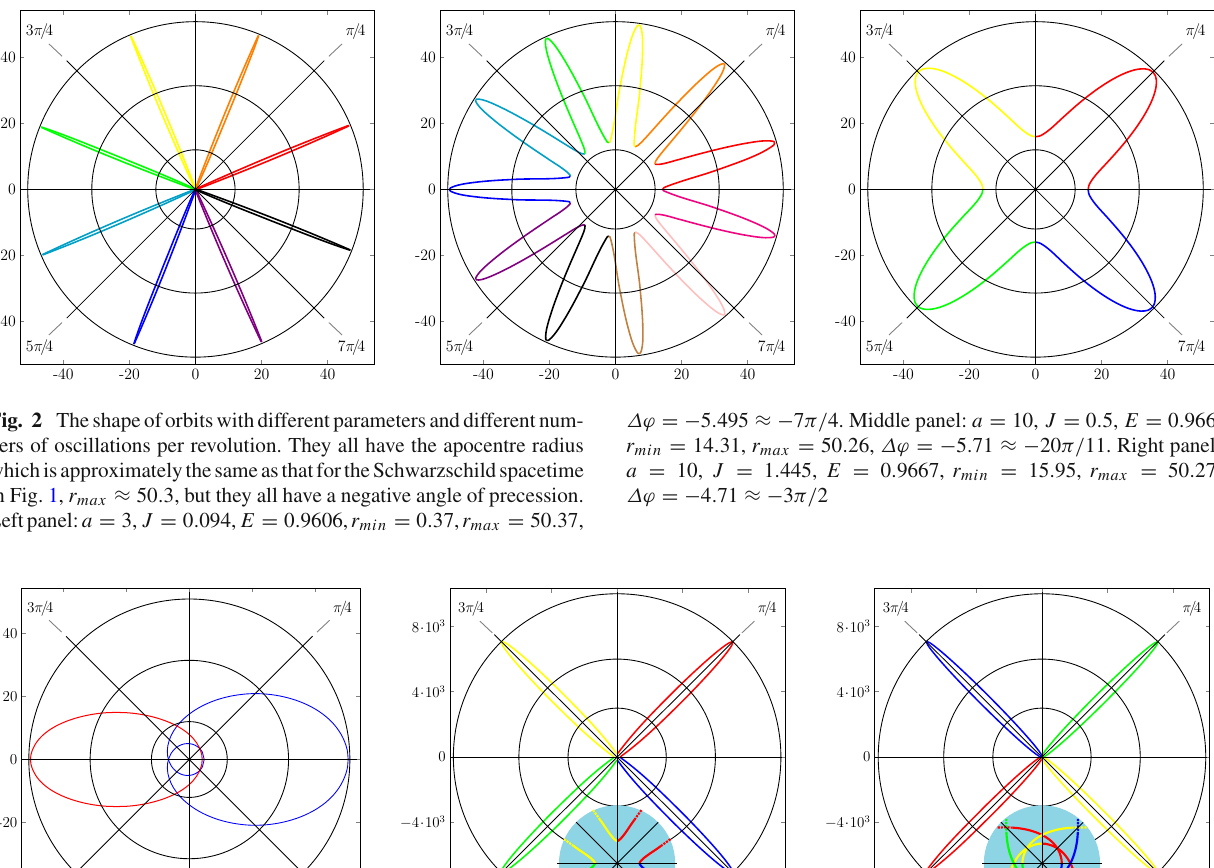
Fig. 3 Left panel: the shape of an orbit around a SFNS (left of center) 50 . 25, Δϕ = + 2 π (the Schwarzschild spacetime). Middle panel: an orbit around a SFNS with parameters a = 50, J = 5 . 66, E = 0 . 9998, and the shape of an orbit in the Schwarzschild spacetime with the same r min = 191 . 1, r max = 9978 . 7, Δϕ = − 4 . 71 = − 3 π/ 2. Right panel: an mass m Sch = m NS = 1 (right of center); these orbits have the same peri- centre and apocentre radii. The parameters of the orbits, respectively, orbit around the Schwarzschild black hole ( m Sch = 1) with parameters J = 4 . 72, E = 0 . 9998, r min = 8 . 54, r max = 9988 . 4, Δϕ = + π/ are: a = 2 . 5, J = 2 . 856, E = 0 . 9635, r min = 4 . 07, r max = 50 . 25, Δϕ = 0 (SFNS), and J = 3 . 88, E = 0 . 966, r = 4 . 70, r = min max